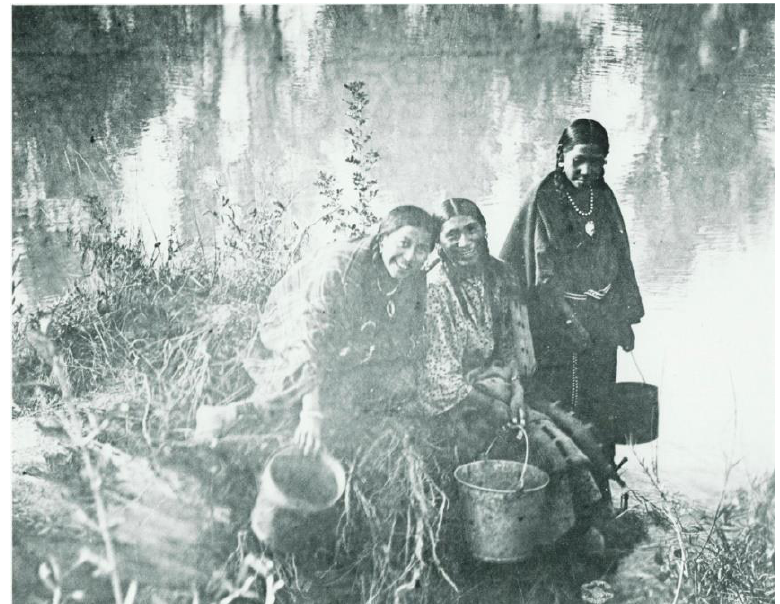
Figure 5. Going after Water—left to right, Mrs. Iron Horse, unidentified woman, and Lucy Drift- wood, gathering water from the Little Bighorn River, ca. 1910. (Photo used with permission from The Crow Indians Photographic College Archives, Crow Agency, Montana. Original at American Anthropological Archives, Washington DC).